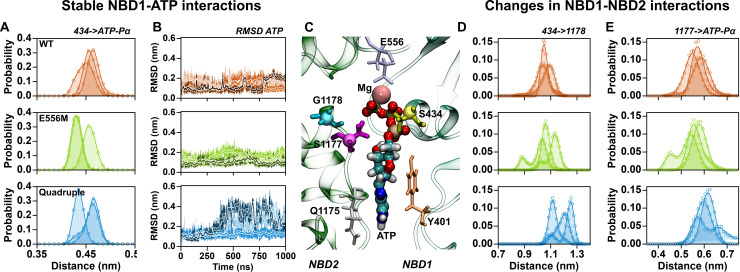
ATP binding to NBS1.(A) Distribution of distances between the Cα atom of residue S434 (Walker A) and the Pα of ATP. (B) Time evolution of the RMSD of ATP in NBS1 after fitting to NBD1. Slight variations in color are used to distinguish the three replicates. (C) Zoom into NBS1 showing the binding mode of ATP. (D) Distribution of distances between the Cα atoms of residue S434 (Walker A) and residue G/R1178 (signature sequence). (E) Distribution of distances between the Cα atoms of residue S1177 (signature sequence) and the Pα of ATP. Data from independent trajectories for wild-type simulations are shown in orange, the trajectories of the catalytic glutamate mutant are shown in green, and data for the quadruple mutant are shown in blue.